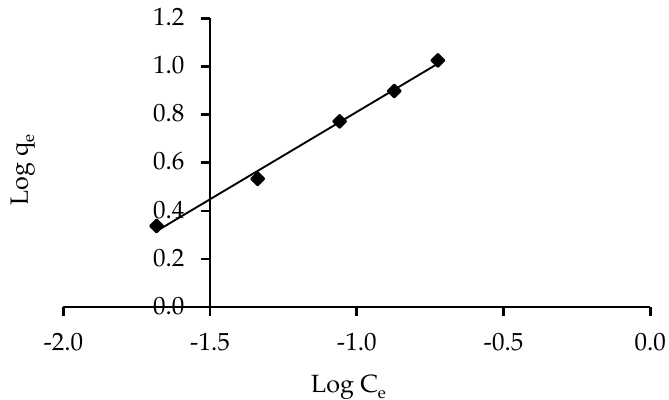
Table 4. Parameters and error function of the isotherm models for IV2R removal by ZnO ‐ NPs.